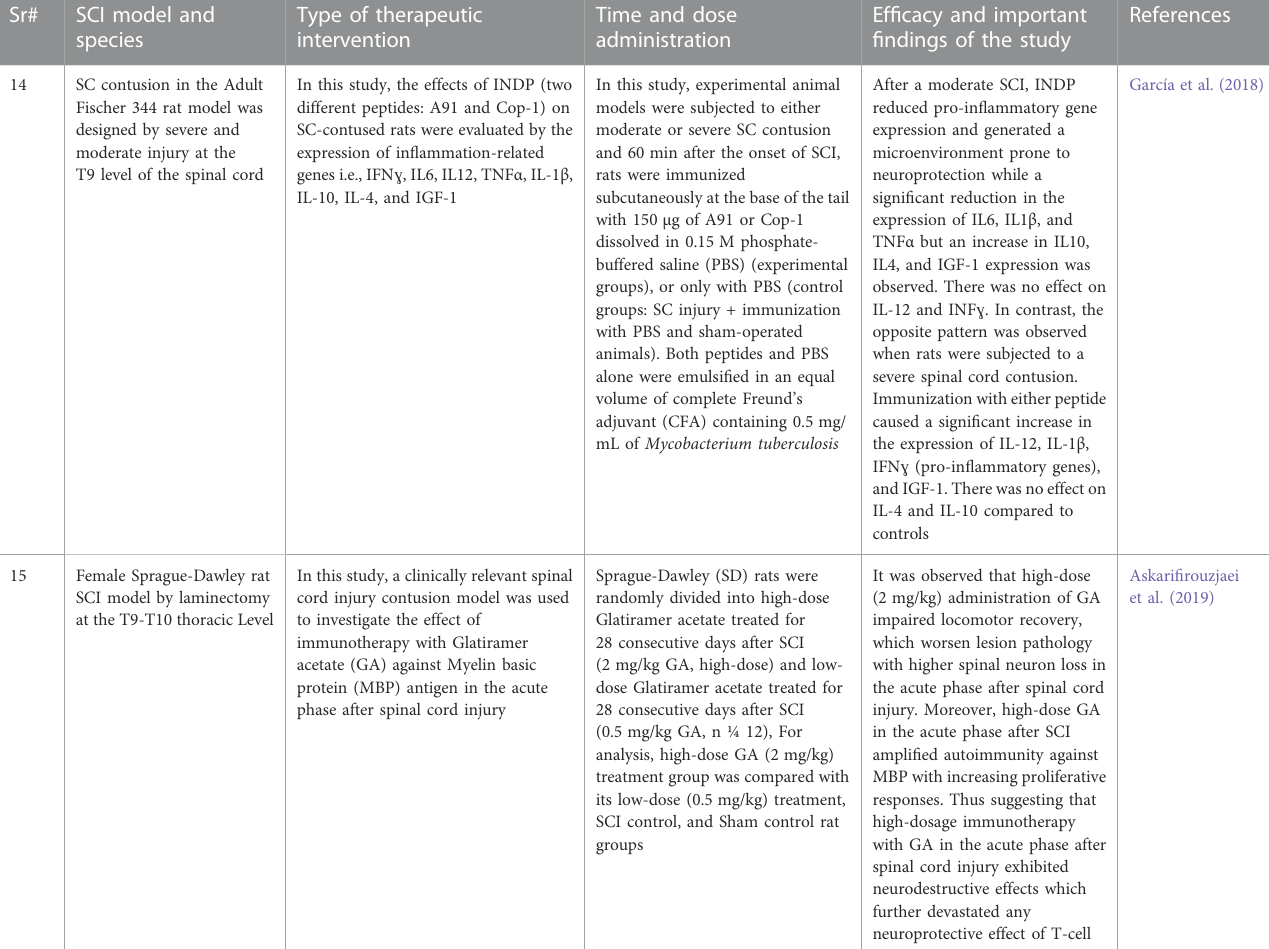
TABLE 1 ( Continued ) Summary of studies using immunotherapy to treat spinal cord